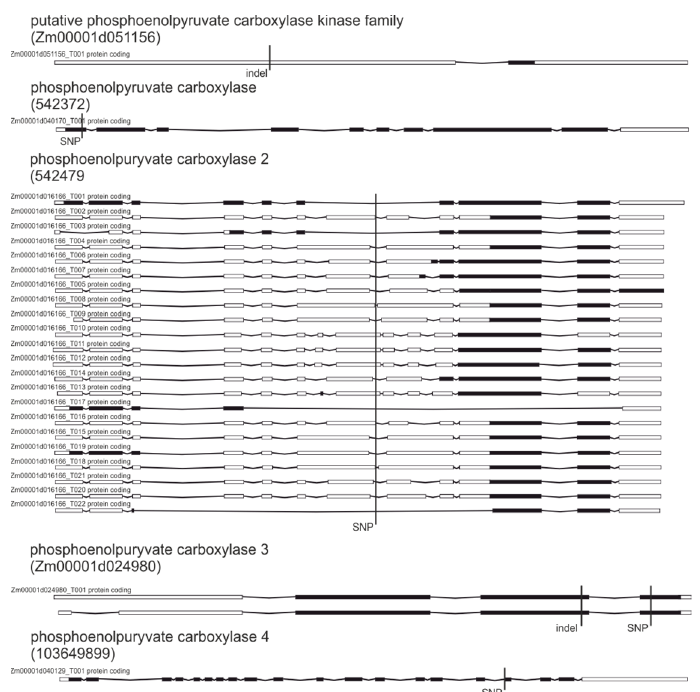
Figure 5. Genetic variations in genes encoding proteins related to lowering the availability of phosphoenolpyruvate for shikimate pathway.